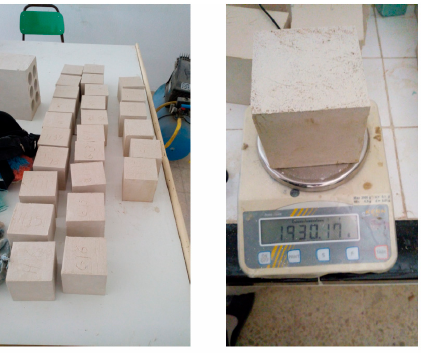
Figure 7. Density measurement process.